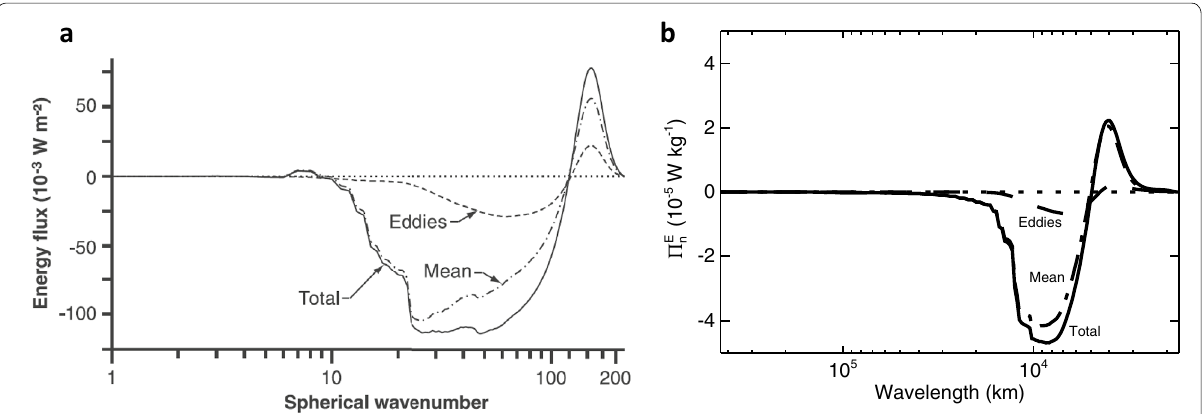
Fig. 4 Spherical harmonic spectral fluxes of KE in model simulations of a Jupiter-like weather layer, obtained by a Schneider and Liu (2009) and b in the Jason model (Young et al. 2019a, 2020). Fluxes in a are averaged over 3 bar in pressure whereas in b this is evaluated (like the observations) at a pressure of 1